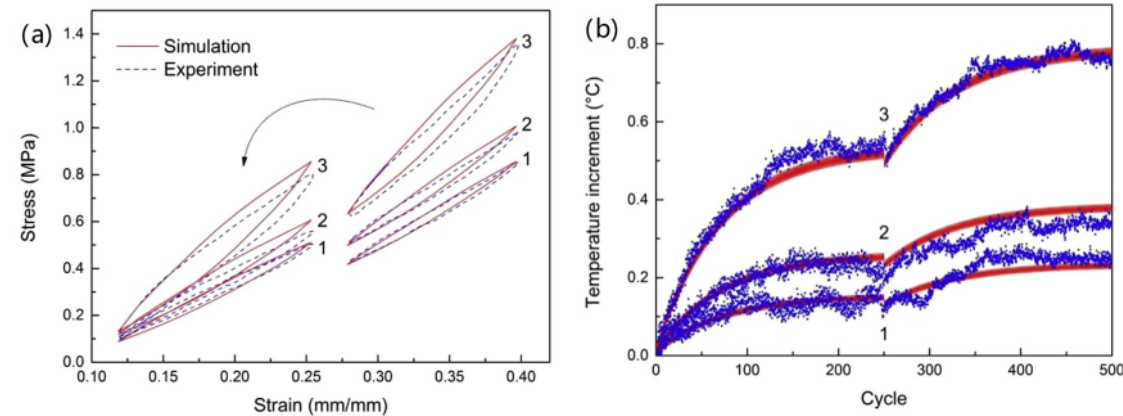
Figure 14. ( a ) Stress–strain curves of two blocks with different pre-tension levels at the 250th cycle. ( b ) Temperature evolution under two blocks with different pre-tension levels (simulation: red solid line, experiment: blue dot) [77].